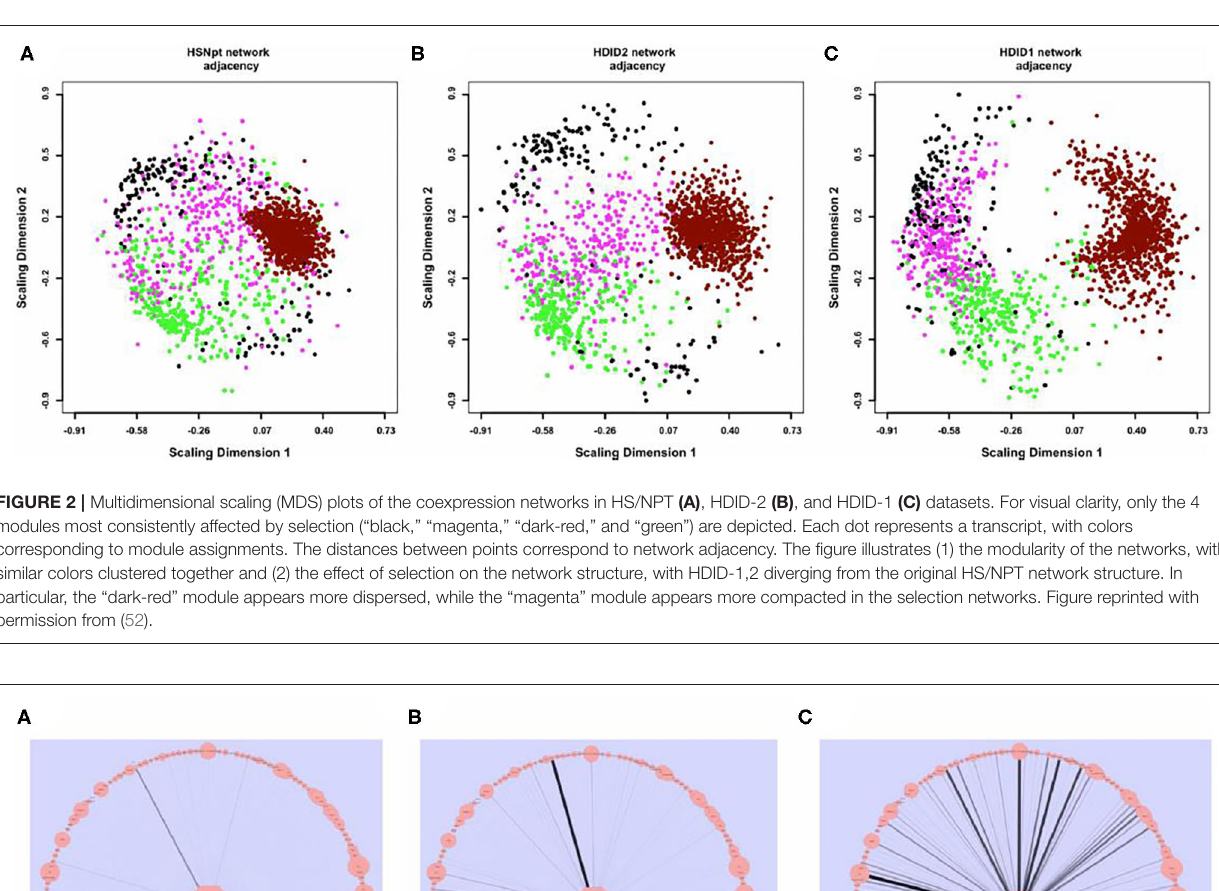
Frontiers in Psychiatry |